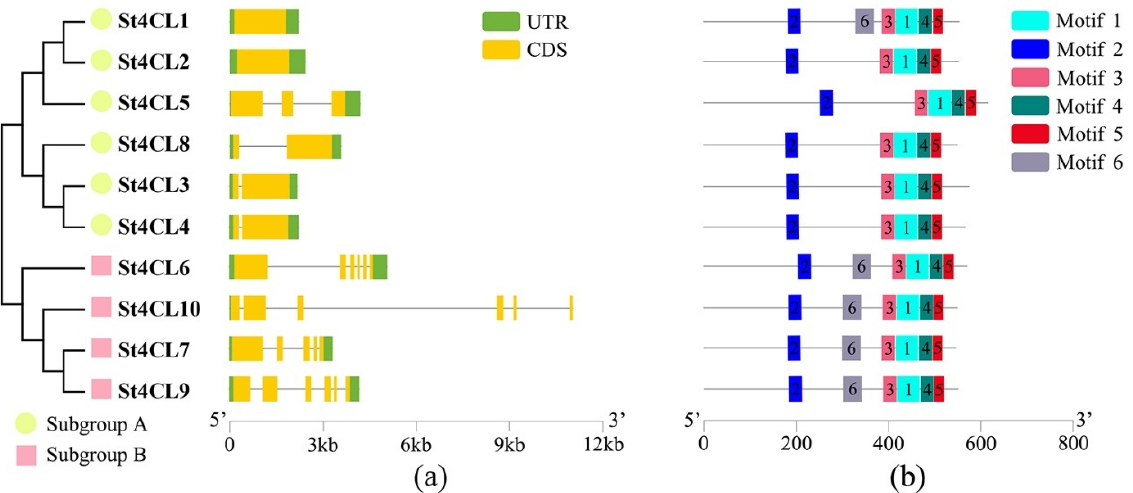
Figure 3. Gene structure analysis and identification of conserved motifs. ( a ) The structural analysis of St4CL gene family members. Green color bars are the UTR regions, yellow color bars are the CDS regions, and the solid black lines represent introns. ( b ) Analysis of conserved motifs in the St4CL gene family.